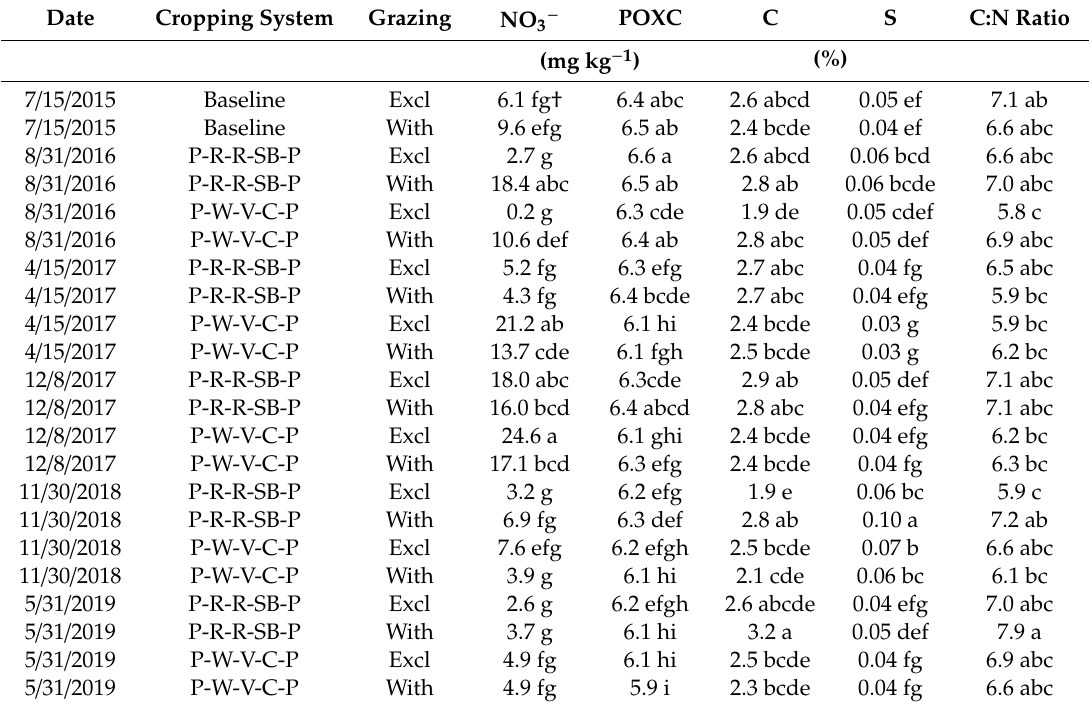
Table 9. NO 3 − , POXC, C, S, and C:N ratio as a function of the interaction between sampling date, cropping systems, and grazing in Pennsylvania